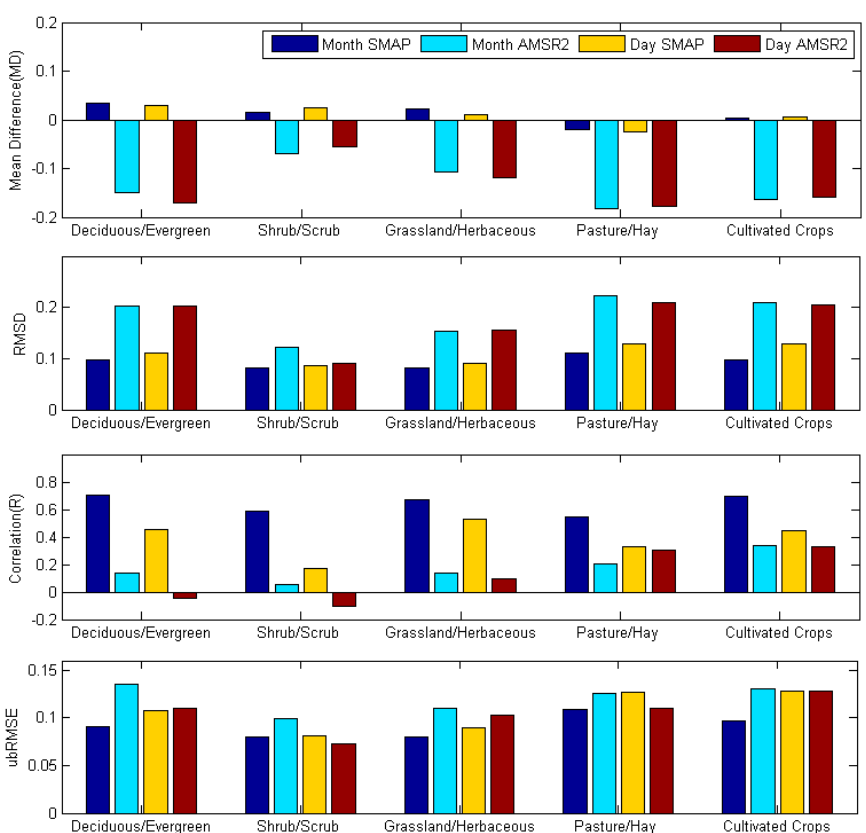
Figure 7. Four statistics results for SMAP L4 SM and AMSR2 L3 SM monthly and daily data with different vegetation cover types.